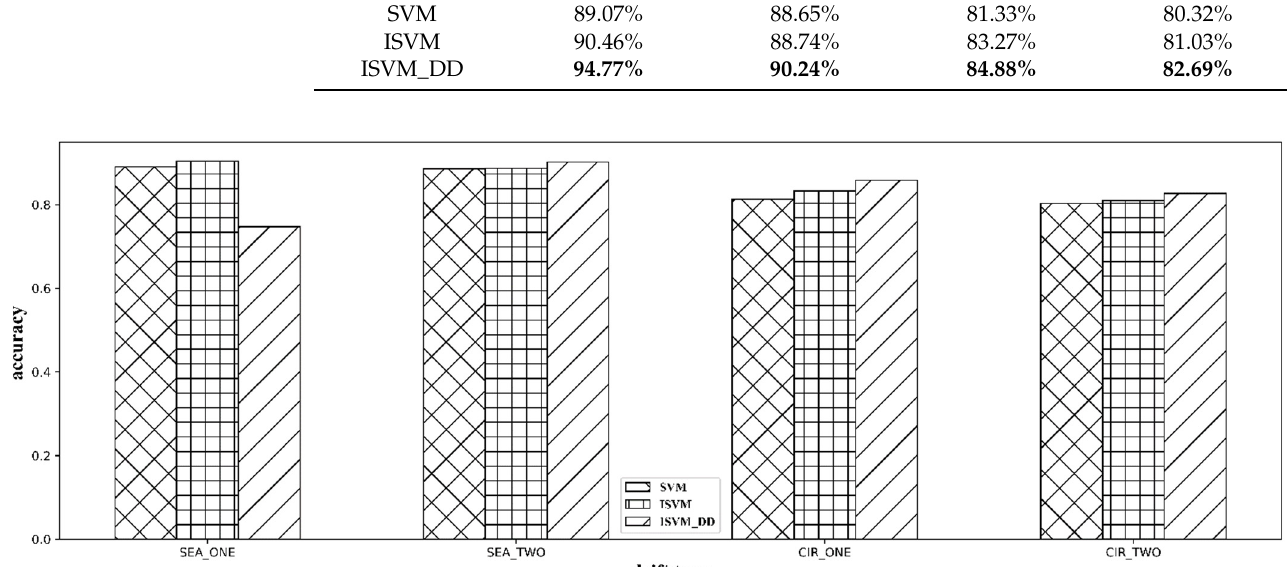
Figure 4. Performance comparison of ISVM_DD on datasets with different types and degrees of concept concept drift.